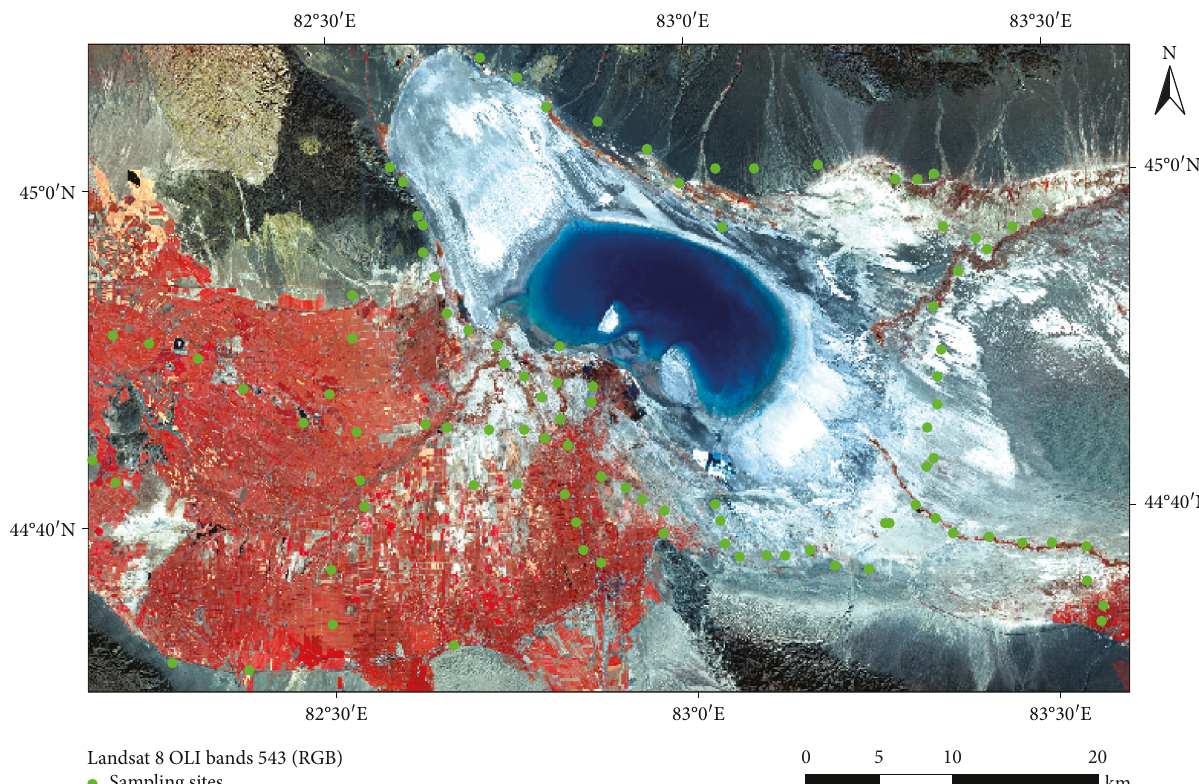
Figure 1: Distribution of the all sampling sites and the location of the study